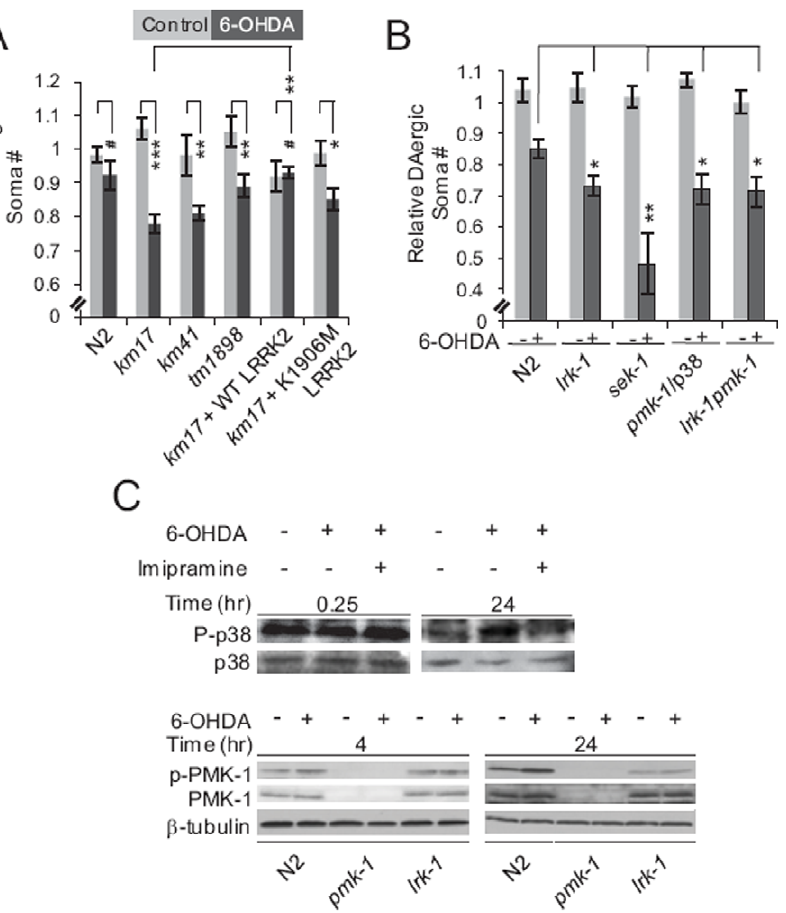
Figure 1. LRK-1 functions upstream of p38 to protect against 6-OHDA-induced DAergic neuron degeneration in C.elegans . ( A ) Human LRRK2 can functionally substitute for LRK-1 to protect against 6-OHDA-induced DAergic neuron degeneration. Day 4 nematodes of the indicated genotypes (N2, three different lrk-1 loss-of-function mutants ( km17 , km41 and tm1898 ), and km17 mutants expressing human WT or K1906M (kinase inactive) LRRK2 in their DAergic neurons) were treated with vehicle (grey bars) or 2 mM 6-OHDA (black bars) for 1 h at L3. DAergic neurons were counted and normalized as described in Experimental Procedures. Data represent the mean 6 SEM of three independent experiments. Each experiment employed 20–30 nematodes. # , p . 0.05, *, p , 0.05, **, p , 0.01, and ***, p , 0.005 by t-test. ( B ) lrk-1 , pmk-1 and sek-1 function in the same genetic pathway to protect against 6-OHDA-induced DAergic neurodegeneration. Day 4 nematodes of the indicated genotypes (N2, km17 mutant ( lrk-1 ), pmk-1 /p38 null ( pmk-1 /p38), lrk-1pmk-1 double null ( lrk-1 / pmk-1 ) and sek-1 /MKK6 null ( sek-1 )) were treated with vehicle (light grey bars) or 2 mM 6-OHDA (dark grey bars) for 1 h at L3. DAergic neurons were counted and normalized as described in Experimental Procedures. Data represent the mean 6 SEM of four independent experiments. Each experiment employed 20–30 nematodes. *, p , 0.05 and **, p , 0.01 by one-way ANOVA with Dunnett’s test. ( C ) 6-OHDA treatment induces p38 phosphorylation in nematodes (upper panel). Nematodes were treated with 2 mM 6- OHDA and 1 mM imipramine for 1 h at L3, and harvested after 15 mins or 24 hrs as indicated above each lane. Western blots were probed with antibodies specific to phosphorylated p38 (P-p38) or total p38. 6-OHDA-mediated induction of p38 phosphorylation in nematodes requires LRK-1 activity (lower panel). N2, pmk-1 mutant or lrk-1 mutant ( km17 ) nematodes were exposed to 2 mM 6-OHDA for 1 hour at L3 and harvested after 4 hrs or 24 hrs. No p38 band was detected by Western blot in lysates from pmk-1 /p38 null mutant animals.